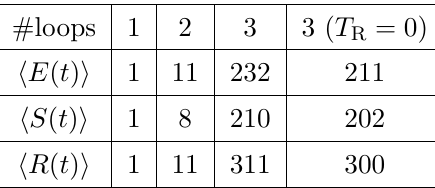
Figure 2 . The only diagram contributing to and R ( t ) (b); and four three-loop diagrams: two diagrams for h i and R ( t ) (e); and one diagram for h i